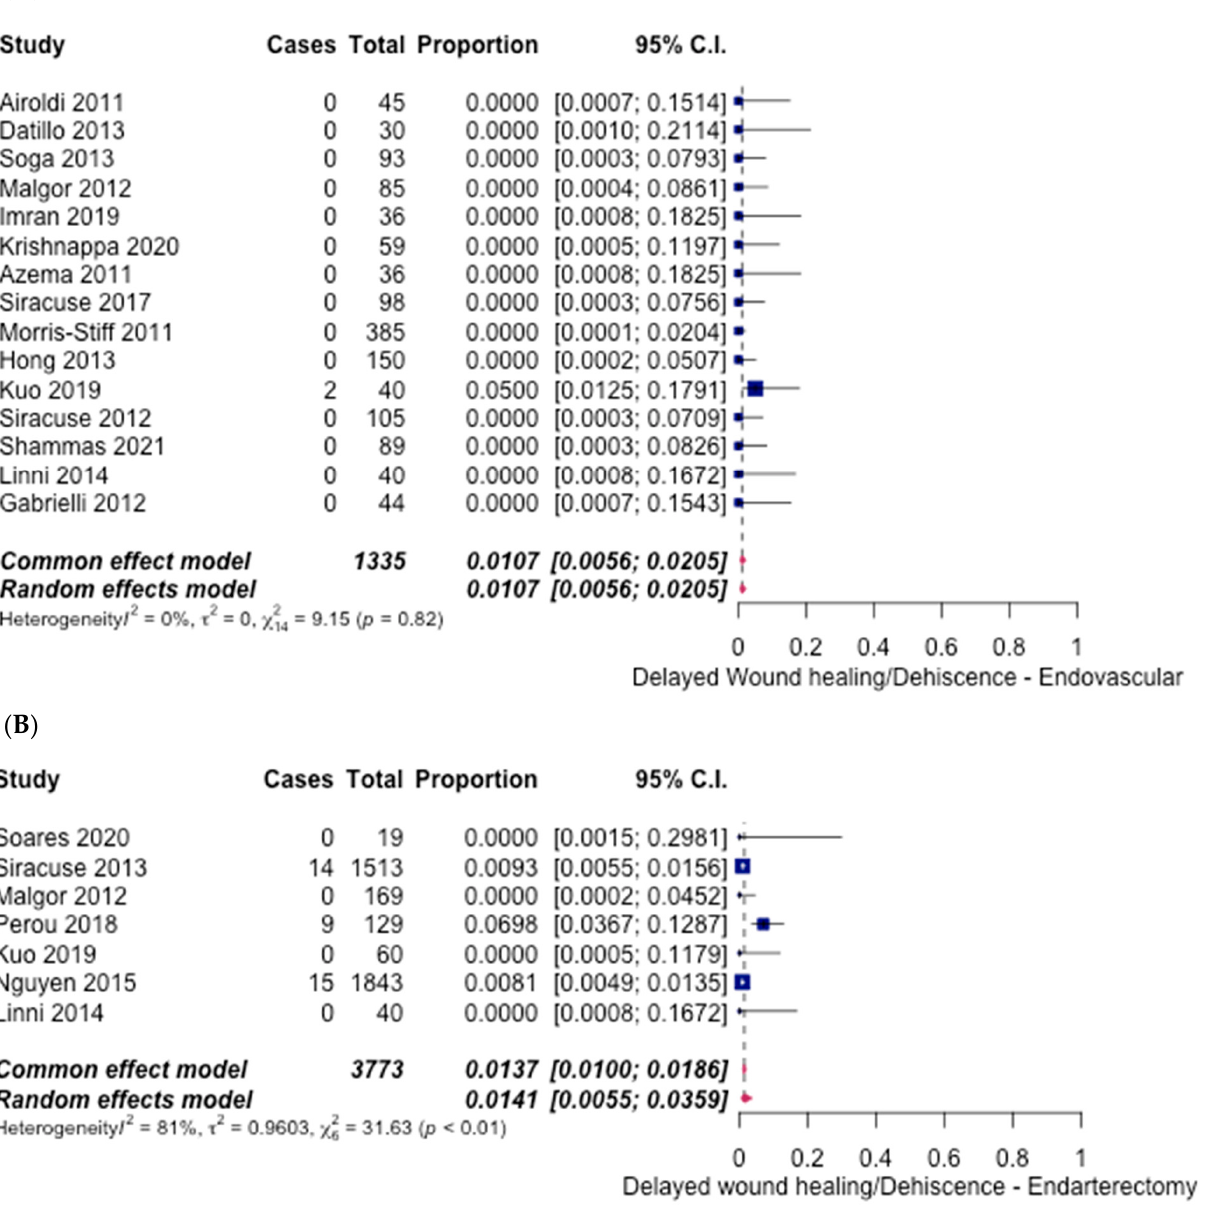
Figure 12. Forest plot for delayed wound healing/dehiscence. ( A ) Endovascular intervention [6,7,9,10,12–16,18,27]. ( B ) Endarterectomy [6,13,21,23,24,29,30]. Other wound-related complications occurred in 16 studies [6,8,10,12–22,27] for ET {1.26% (95% CI [0.47%, 3.31%])} (Figure 13A) and 10 studies [6,13,21,23–26,28–30] for FAE {1.21% (95% CI [0.49%, 2.99%])} (Figure 13B). No significant difference was noted between the two groups, with an odds ratio of 1.04 (95 CI [0.67–1.63], p = 0.87).